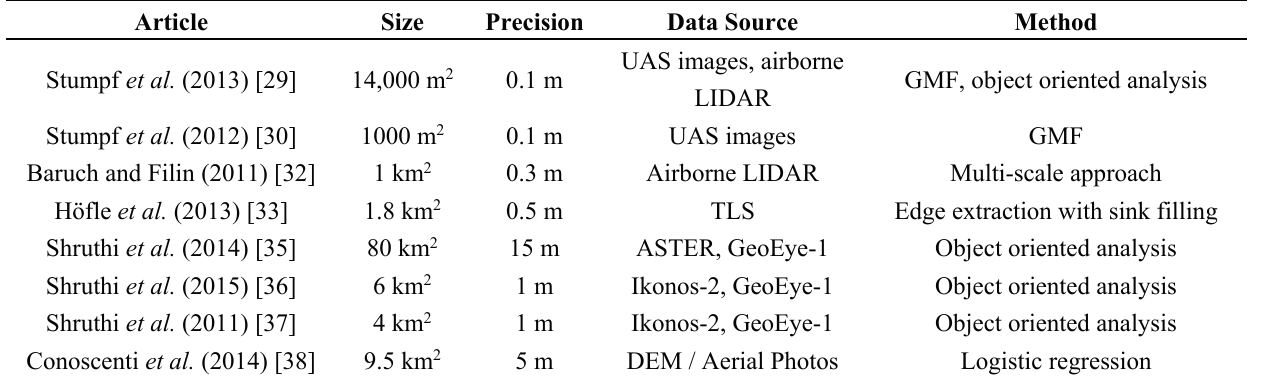
Table 1. The scope of some related